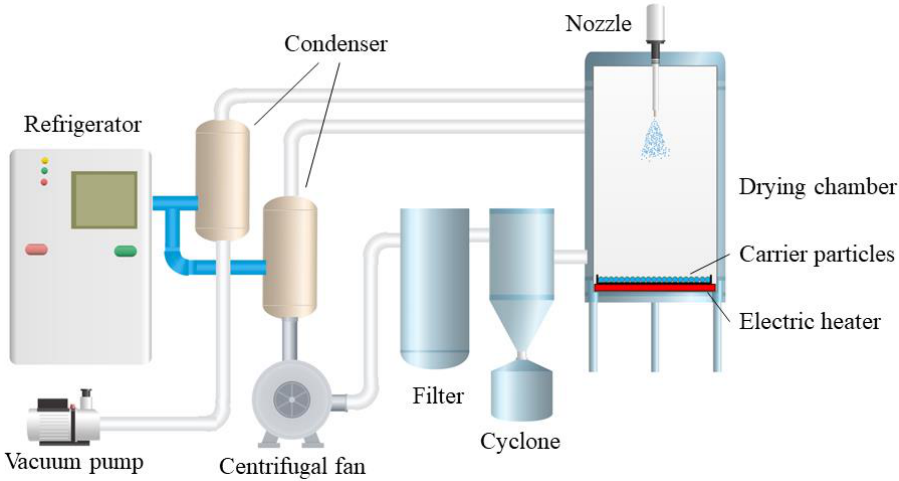
Figure 2. Flow chart of carrier particle spray freeze-drying device [10].